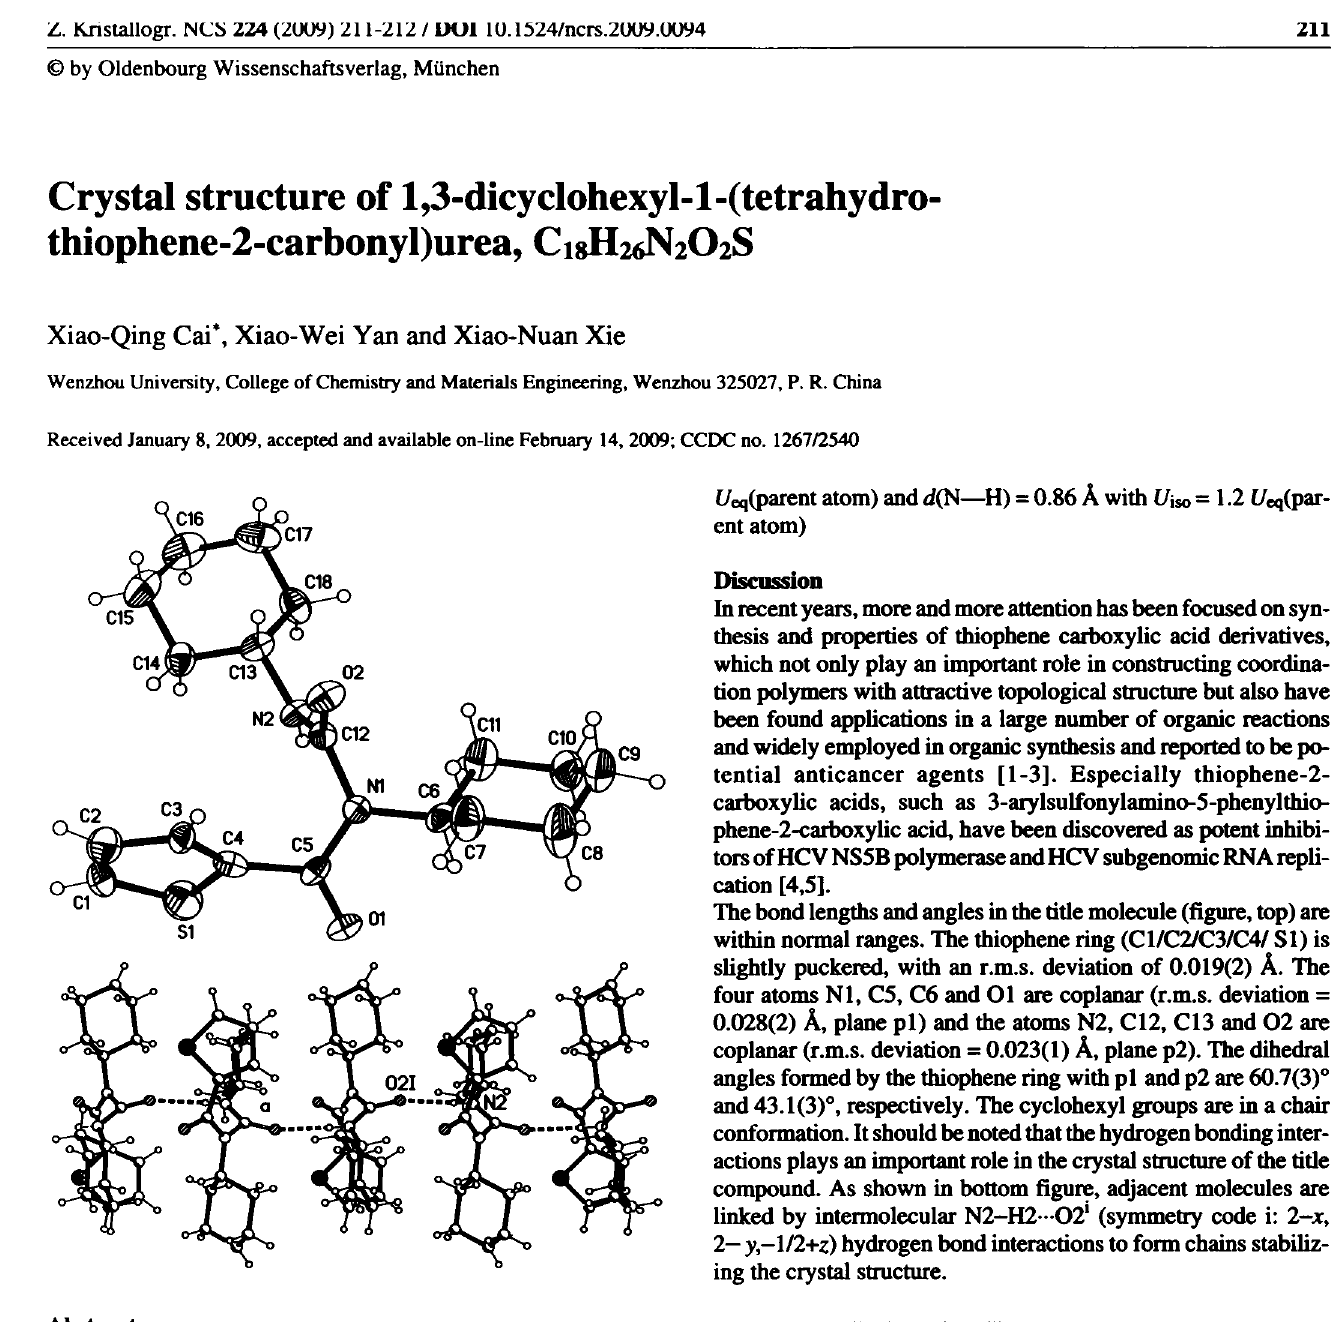
Table 1. Data collection and handling.